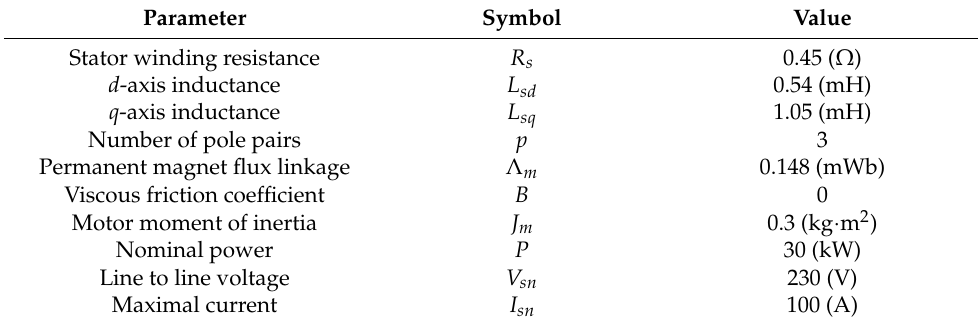
Table 1. IPMSM used parameters [42].